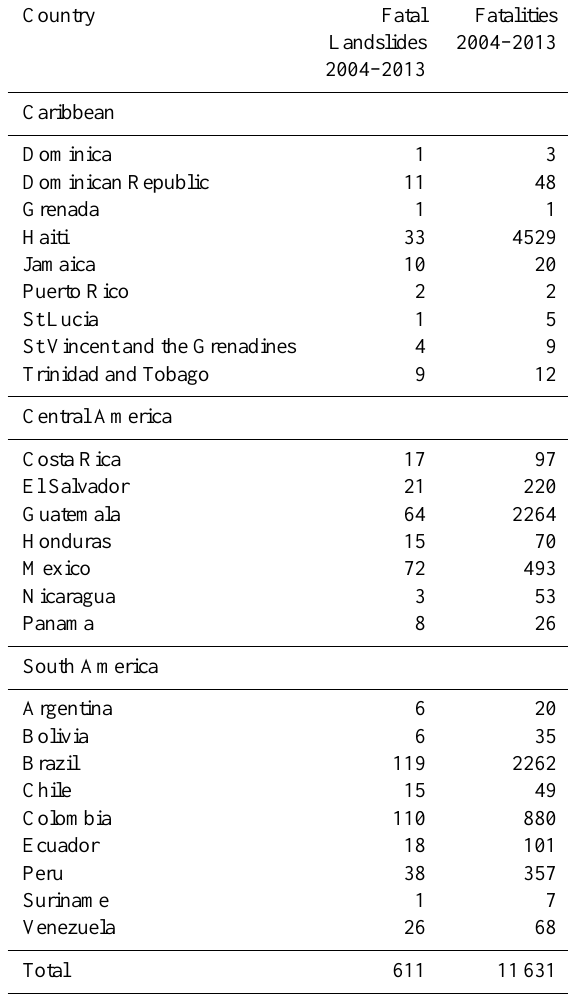
Table 1. Number of fatal landslides and fatalities for each country with positive cases. Country